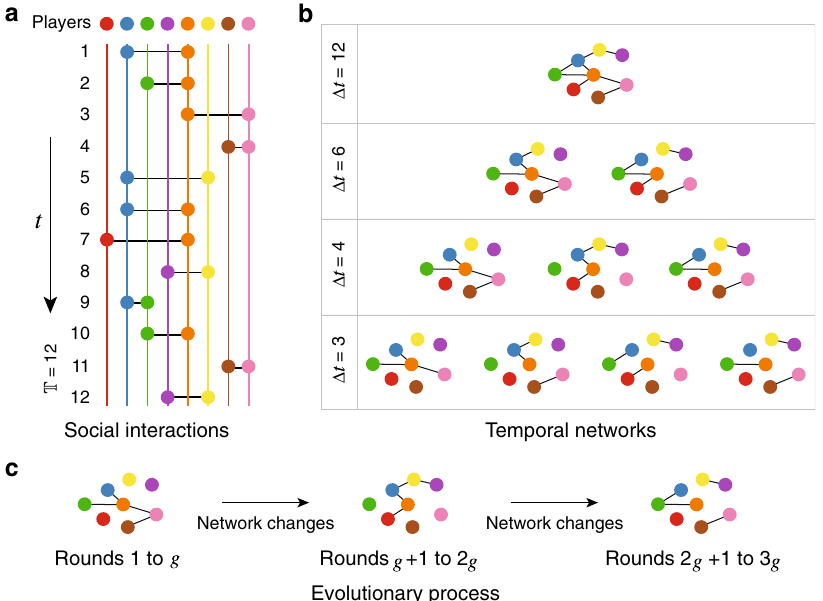
Fig. 1 Construction of temporal networks from intermittent social interactions. a Social interactions between 8 individuals indicated by solid circles with different colours. Along the whole time from t ¼ 1 to t ¼ T , each individual is depicted by the same colour line, over which the corresponding circles will be given and connected with each other at time t provided two players interact with each other during the time interval ð t (cid:2) τ ; t (cid:3) . Here τ ¼ 1 for the simplicity of visualisations, and normally in the real data collected by SocioPatterns (see Methods), τ ¼ 20s. b Four different temporal networks that arise from aggregating the interactions shown in a into snapshots using different time windows Δ t . When Δ t ¼ T , all interactions are captured in a single snapshot, corresponding to the static network that is the typical object of study in social network data. In general, when Δ t < T , we have T = Δ t d e snapshots. c The de fi nition of evolutionary process on temporal networks. Taking the temporal network corresponding to Δ t ¼ 4 in ( b ) as an example, we perform g rounds of evolution in each snapshot before changing the network structure to the next one, and totally we run G rounds. If T = Δ t d e g < G , we repeat the sequence of snapshots from the